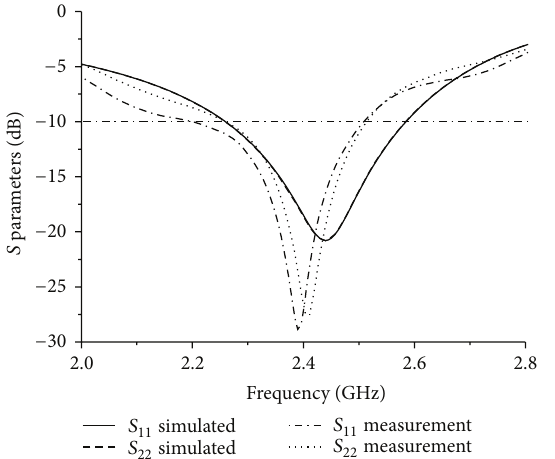
Figure 9: Simulated and measured 𝑆 parameters of the proposed MIMO antenna system.